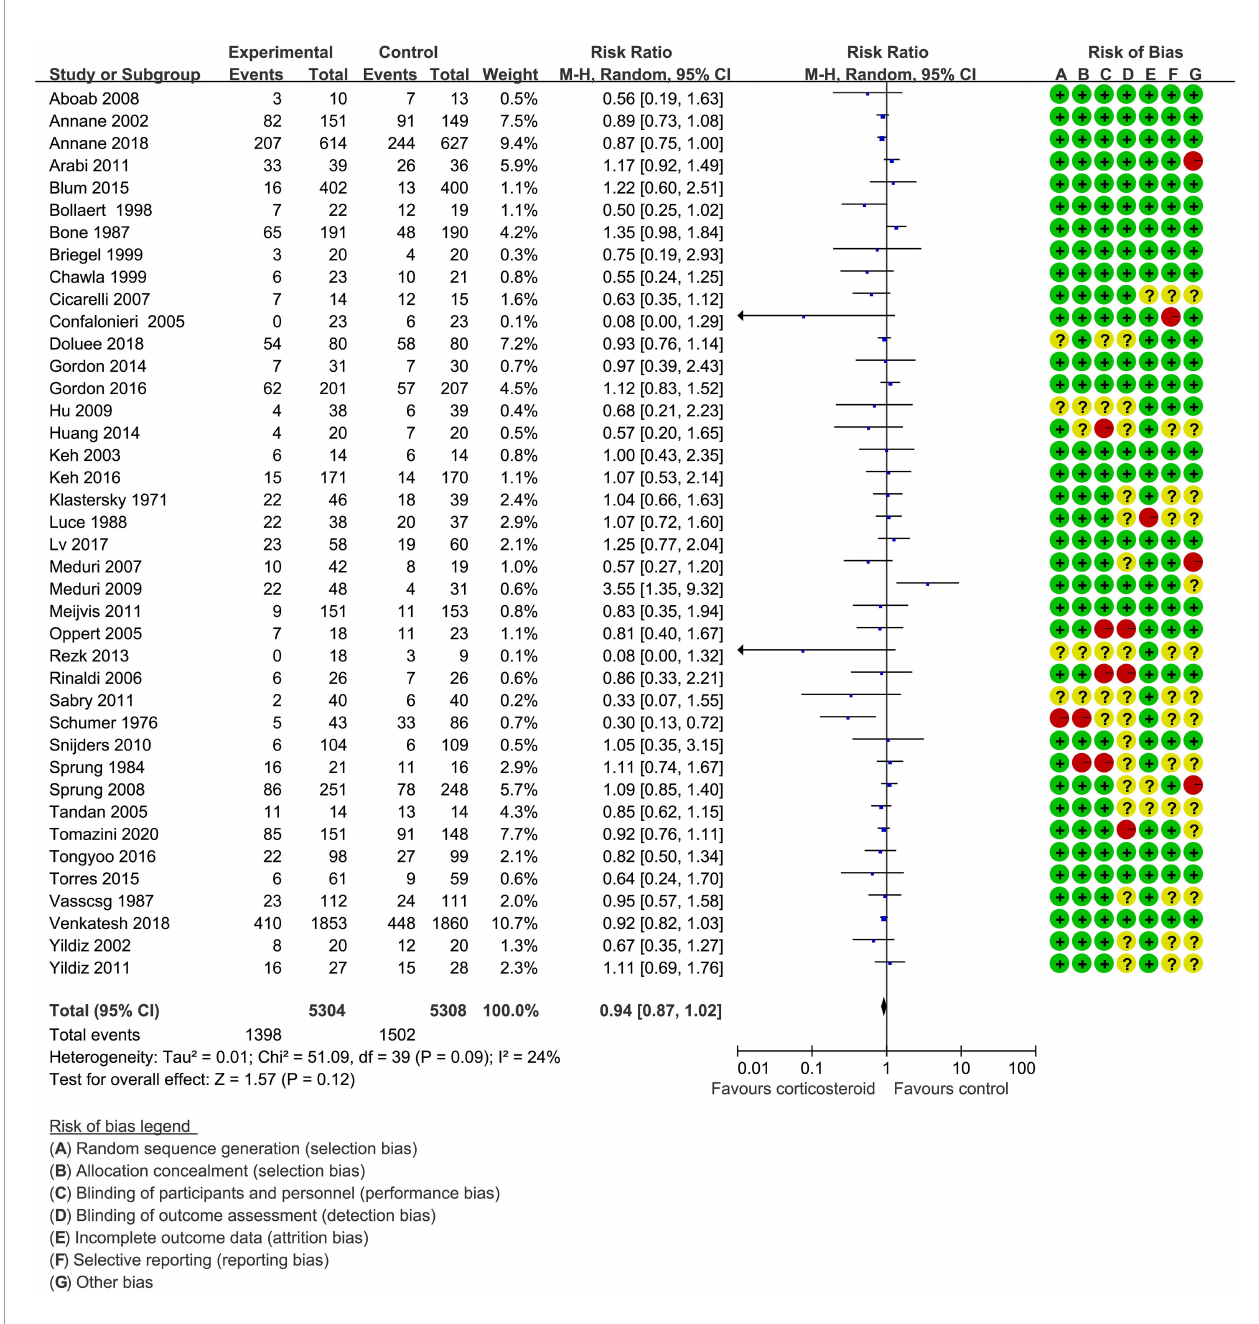
FIGURE 2 | The 28-day mortality of patients with sepsis based on the corticosteroids treatment. The pooled effects in the forest plot were calculated by the M-H method with the random-effects